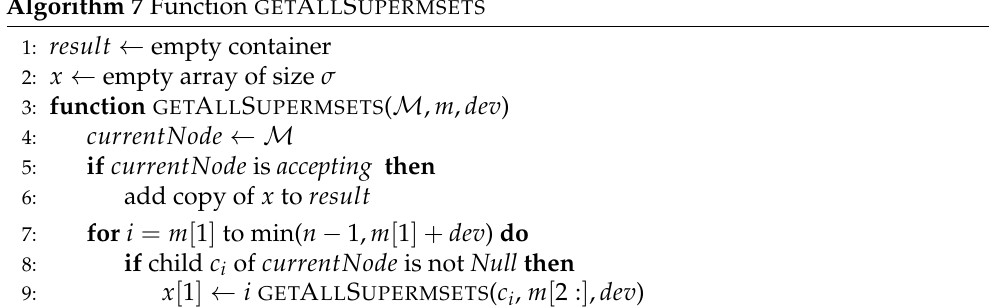
Algorithm 7 Function GET A LL S